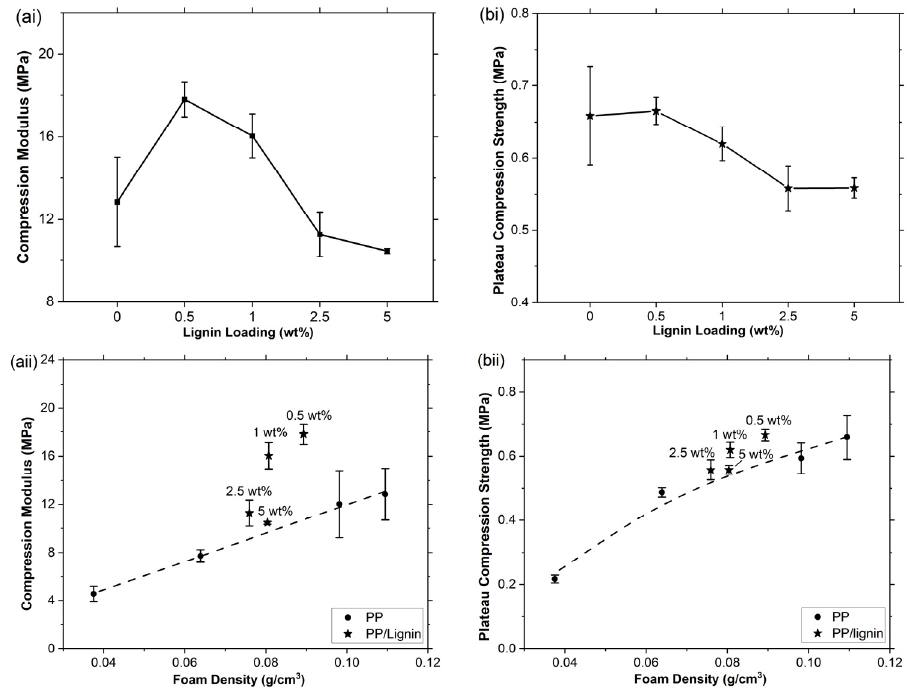
Figure 6. ( a ) Compression modulus, ( b ) plateau compression strength of the PP and PP/lignin foams as a function of ( i ) lignin loading and ( ii ) foam density.